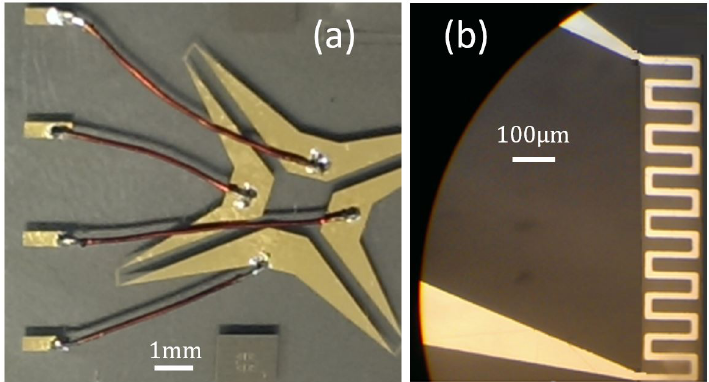
Figure 17. ( a ) Micro fabricated gold sensor, design revision 1.0 ( b ) Close up of the sensing element.